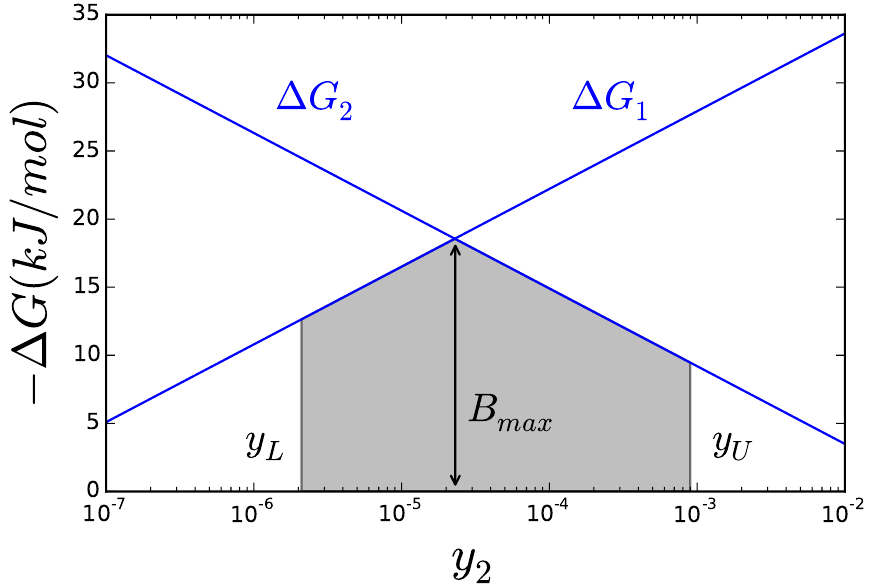
Figure 3. The lines represent the ∆ G of each reaction. The area below both curves (shaded) covers all possible values for B . The maximal possible value of B is obviously the intersection between the two